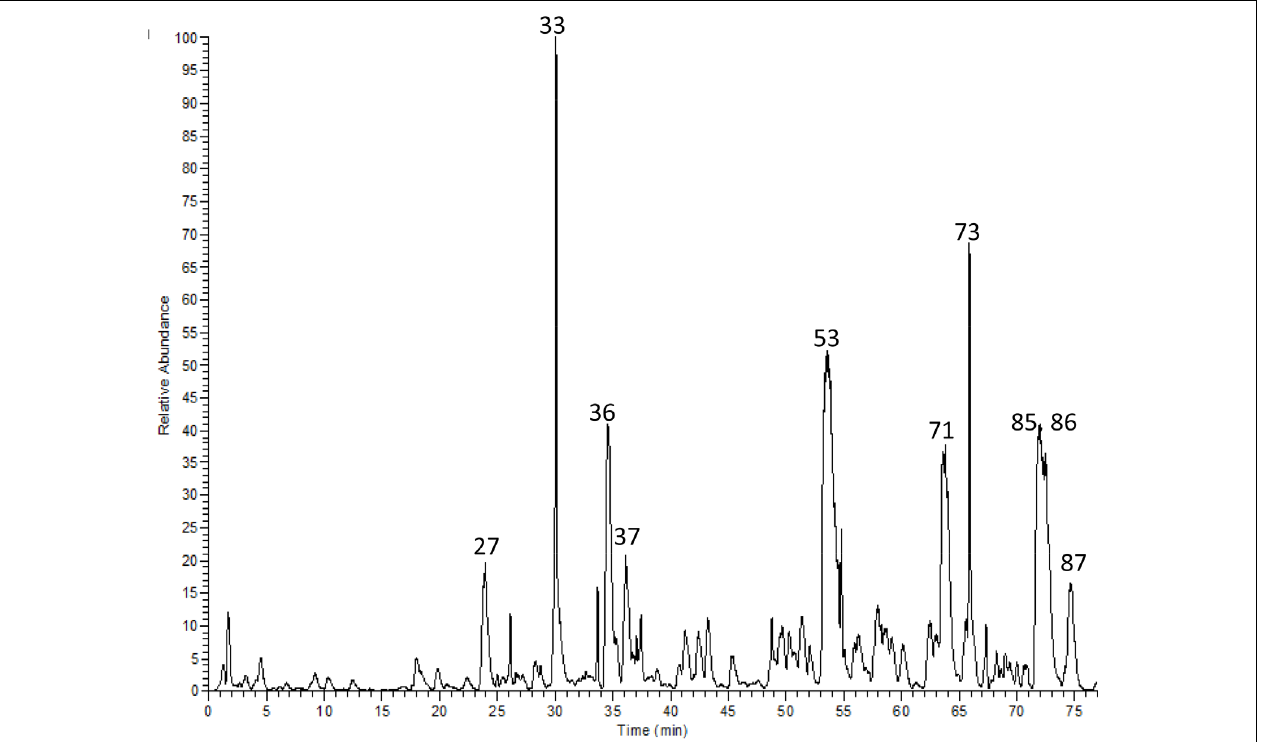
FIGURE 1 | HR-LC-MS/MS chromatogram of a methanol extract from S. aqueum leaves.